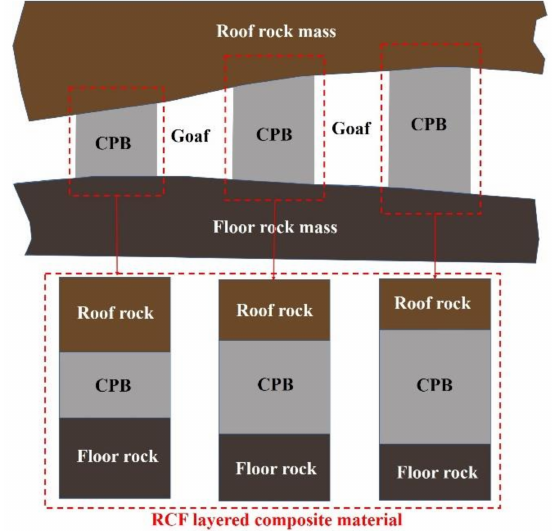
Figure 1. Layered composite material in mining field and laboratory of roof rock–CPB–floor rock (RCF).